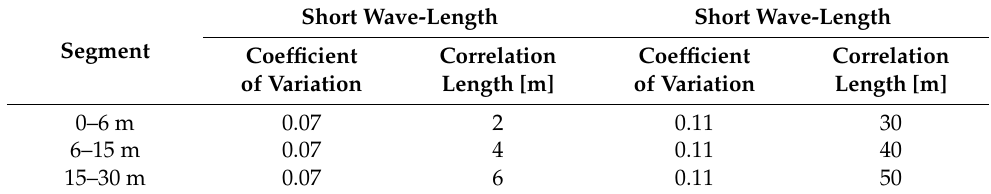
Table 2. Probabilistic Vs and D profile generation parameters [49].